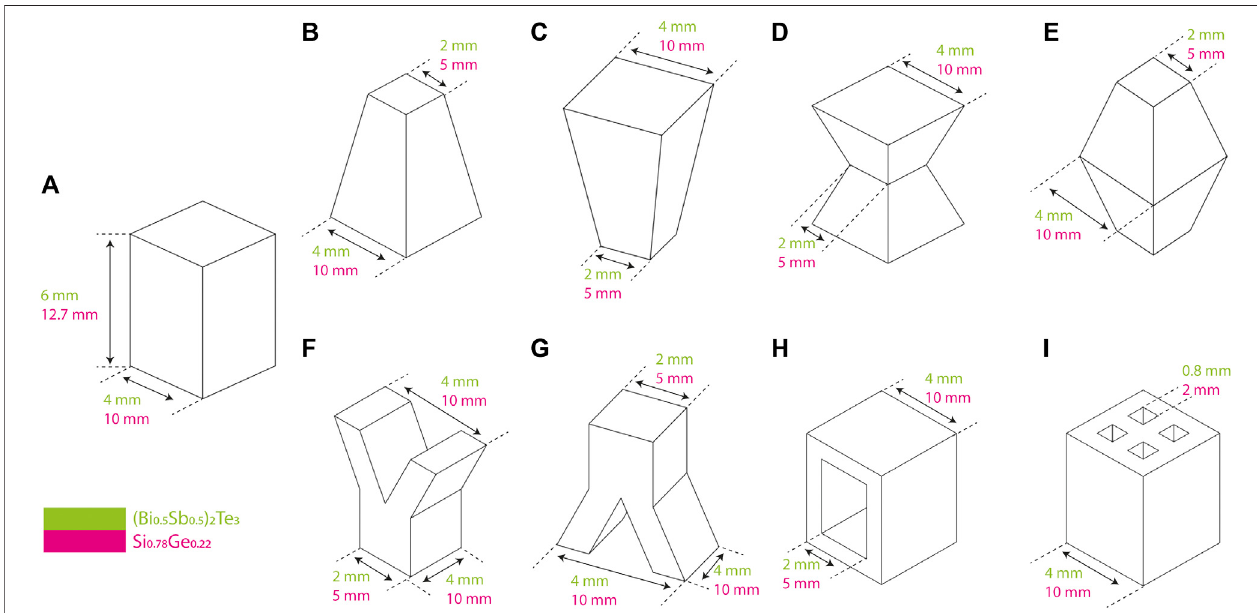
FIGURE 2 | Thermoelectric leg shapes investigated in this study were: (A) rectangular (the conventional leg shape), (B) trapezoid, (C) reverse trapezoid, (D) hourglass, (E) inverse hourglass, (F) Y, (G) reverse Y, (H) hollow rectangular, and (I) multi-hollow rectangular.